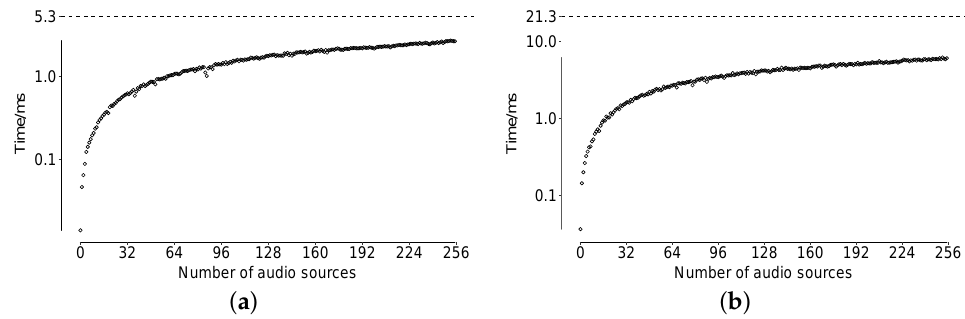
Figure 5. CPU time used for the spatializer for different number of audio sources with different audio block sizes: 256 samples (Desktop version) and 1024 samples (VR version). Dashed lines indicate the block processing time in each case. ( a ) 256samples. ( b )